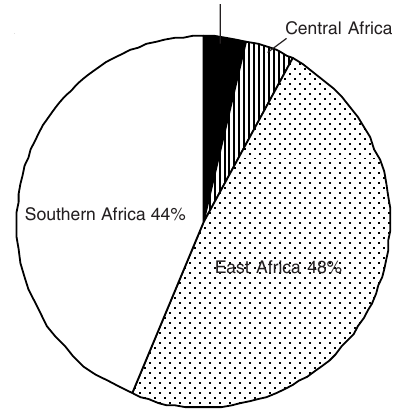
Figure 1. Distribution of lions in Africa (Bauer & van der Merwe 2004)